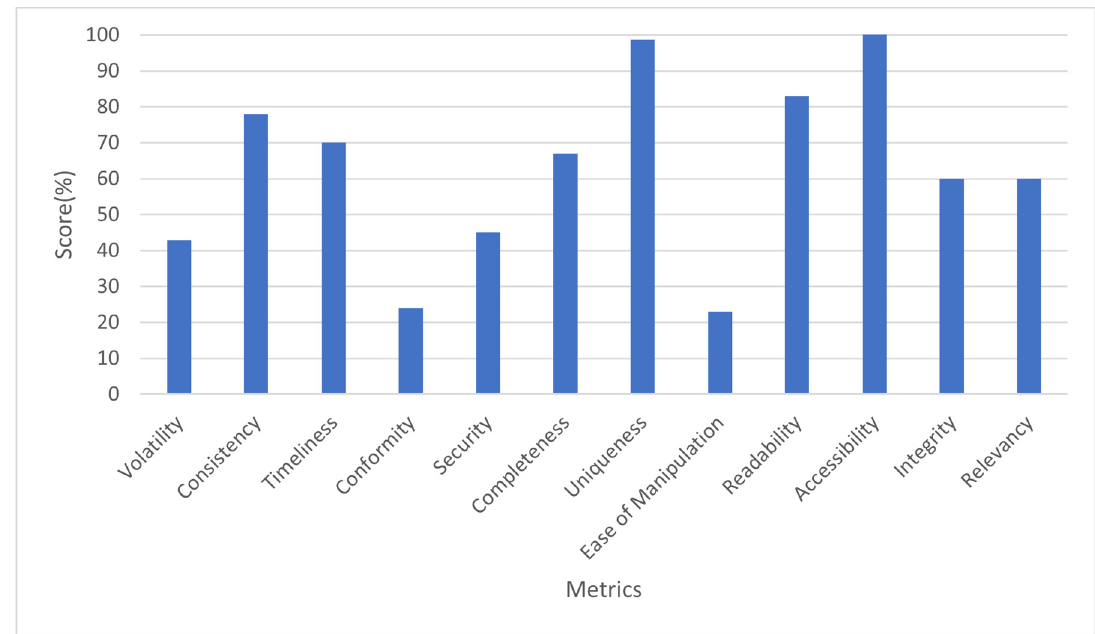
Figure 6. Data Quality Metric Scores.